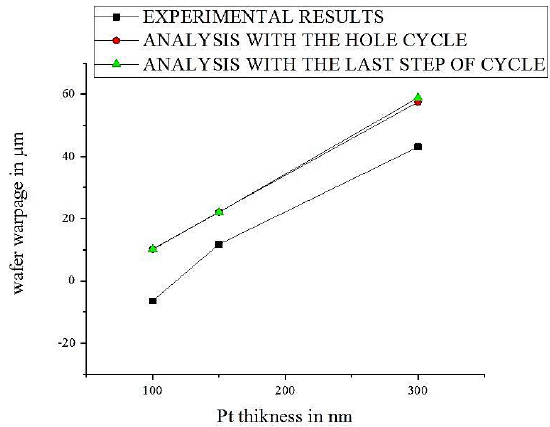
Figure 7. Numerical results and experimental measurements [3] of Si/USG/Pt warpage.